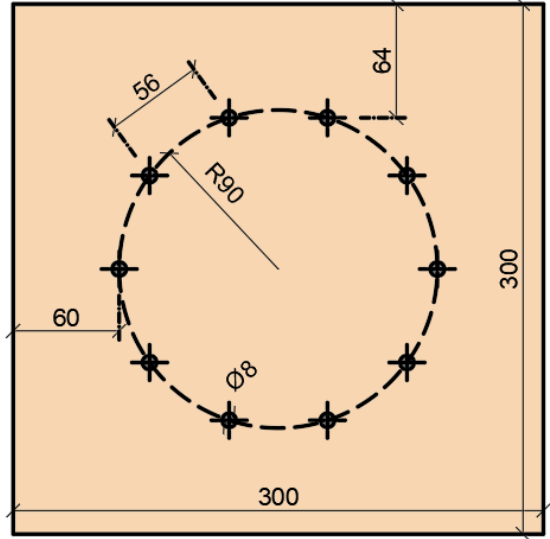
Figure 1. The arrangement of fasteners.